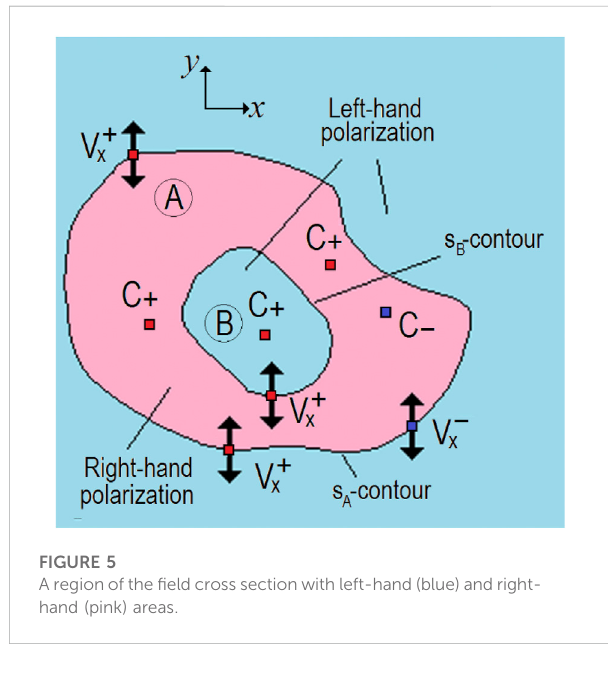
FIGURE 5 A region of the fi eld cross section with left-hand (blue) and right- hand (pink) areas.